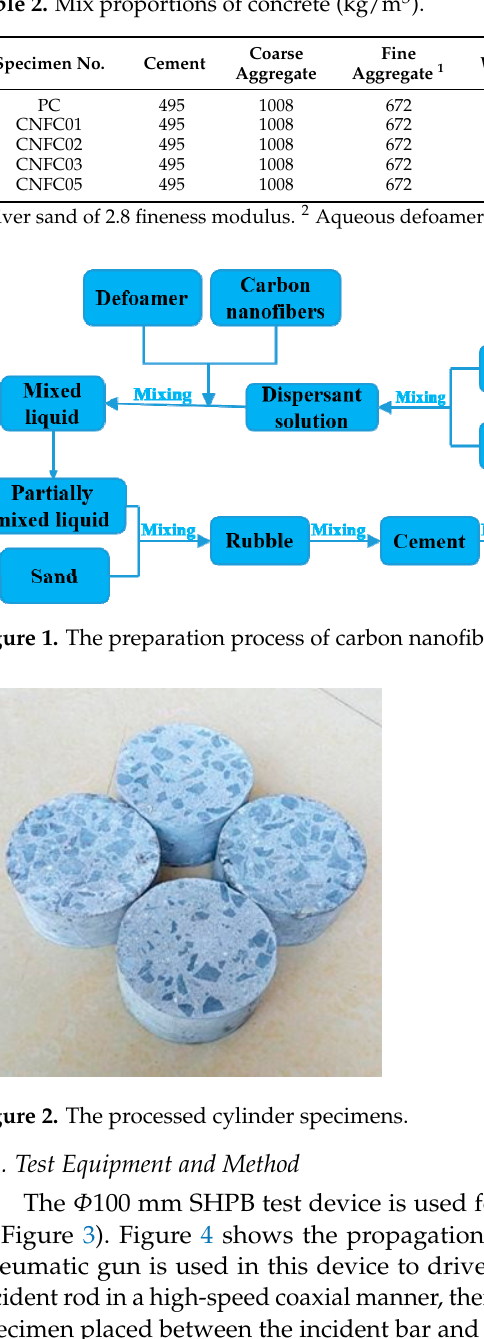
Table 2. Mix proportions of concrete (kg/m 3 ).